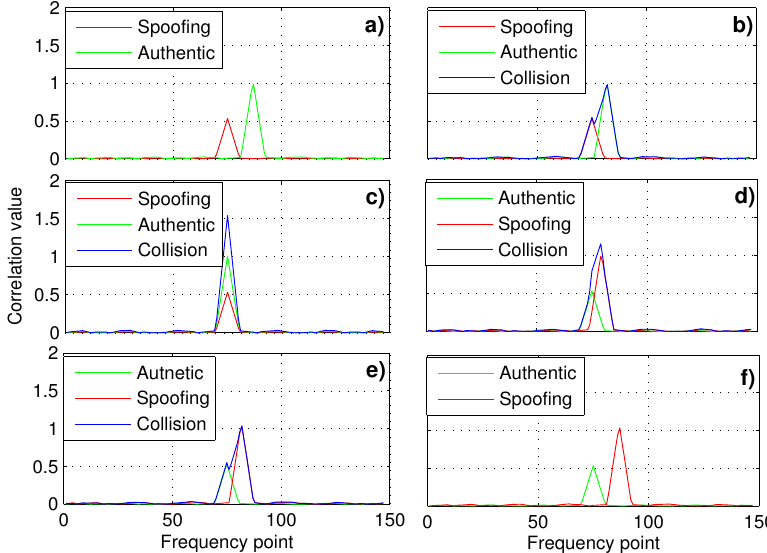
Figure 1. Schematic diagram of the induced spoofing attack process. In ( a ), the spoofing lags the authentic signal with a lower power. From ( a ) to ( c ), the spoofing gradually approaches the authentic signal. Subsequently, the power of spoofing is greater than that of the authentic signal and the receiver is gradually controlled by the spoofing in ( d – f